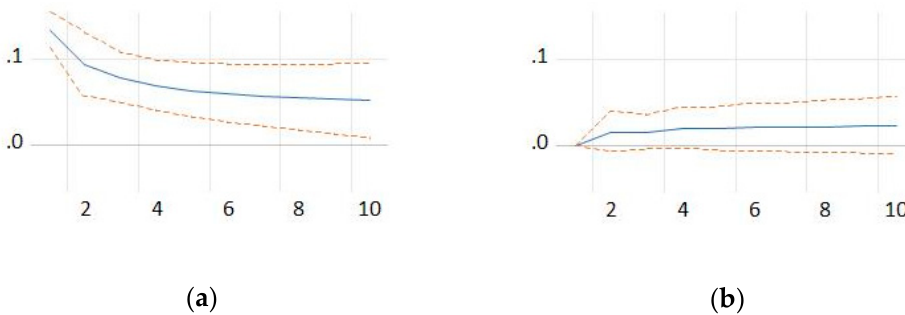
Figure 7. Response of deaths of enterprises to a shock from: ( a ) deaths of enterprises; and ( b ) persons employed in the population of births. Source: the authors’ own computations.